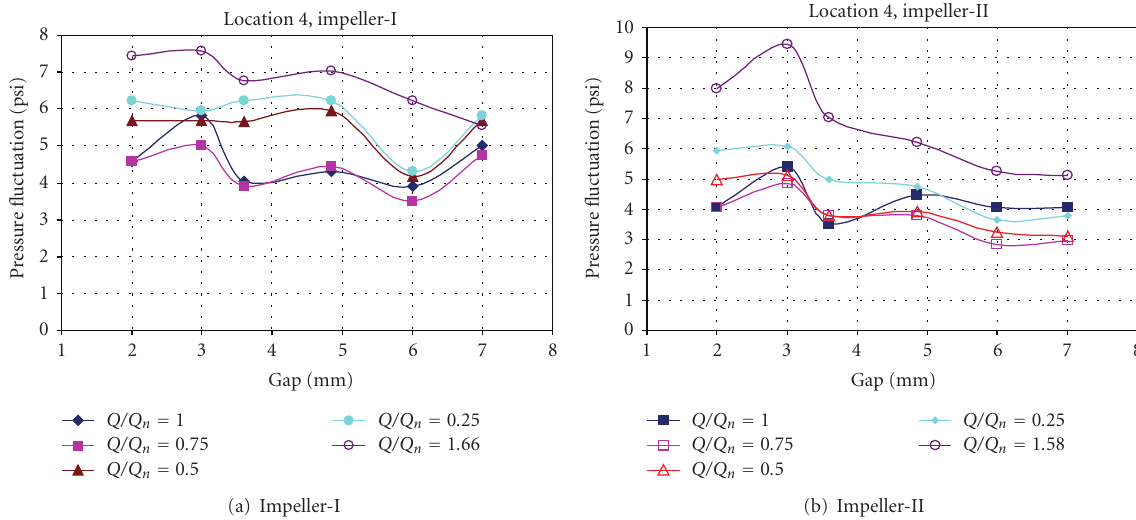
Figure 8: Variation of pressure fluctuations with radial gap at di ff erent flow